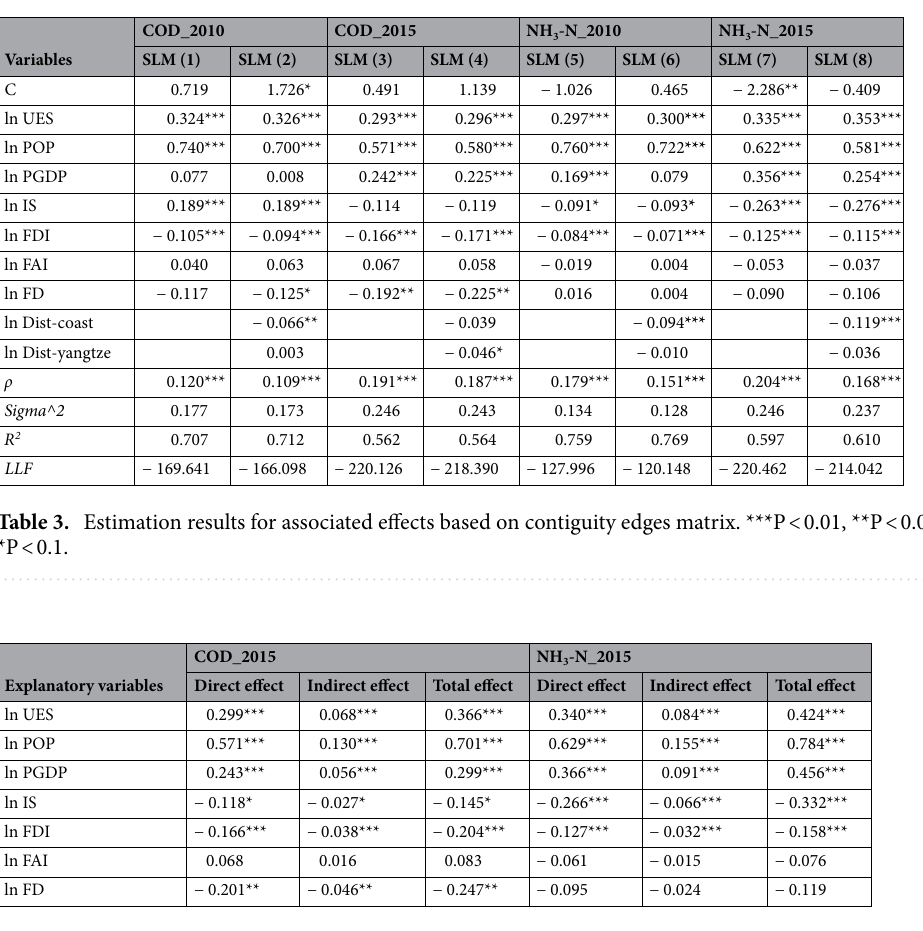
Table 4. Decomposition results for the spatial effects based on contiguity edges matrix. ***P < 0.01, **P < 0.05 and *P < 0.1.